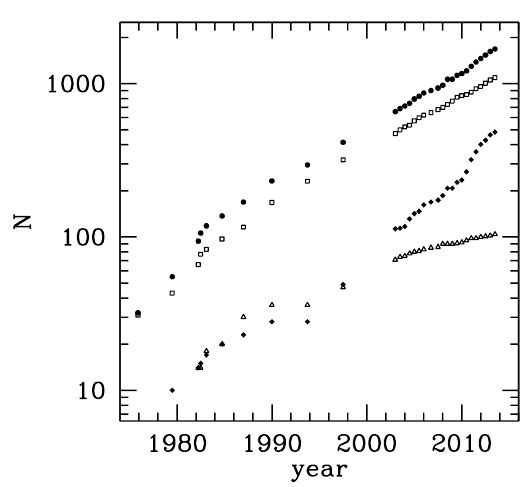
Figure 1: Number of CVs (open squares), LMXBs (open triangles), and related objects (filled diamonds), as well as the total number of objects (filled circles) con- tained in Rcat/RKcat and its precursors as a function of